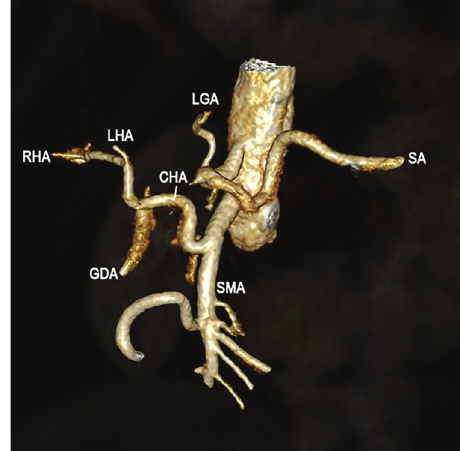
Figure 7 - Three-dimensional reconstruction CTA image shows a coeliacomesenteric trunk (CMT) variation.